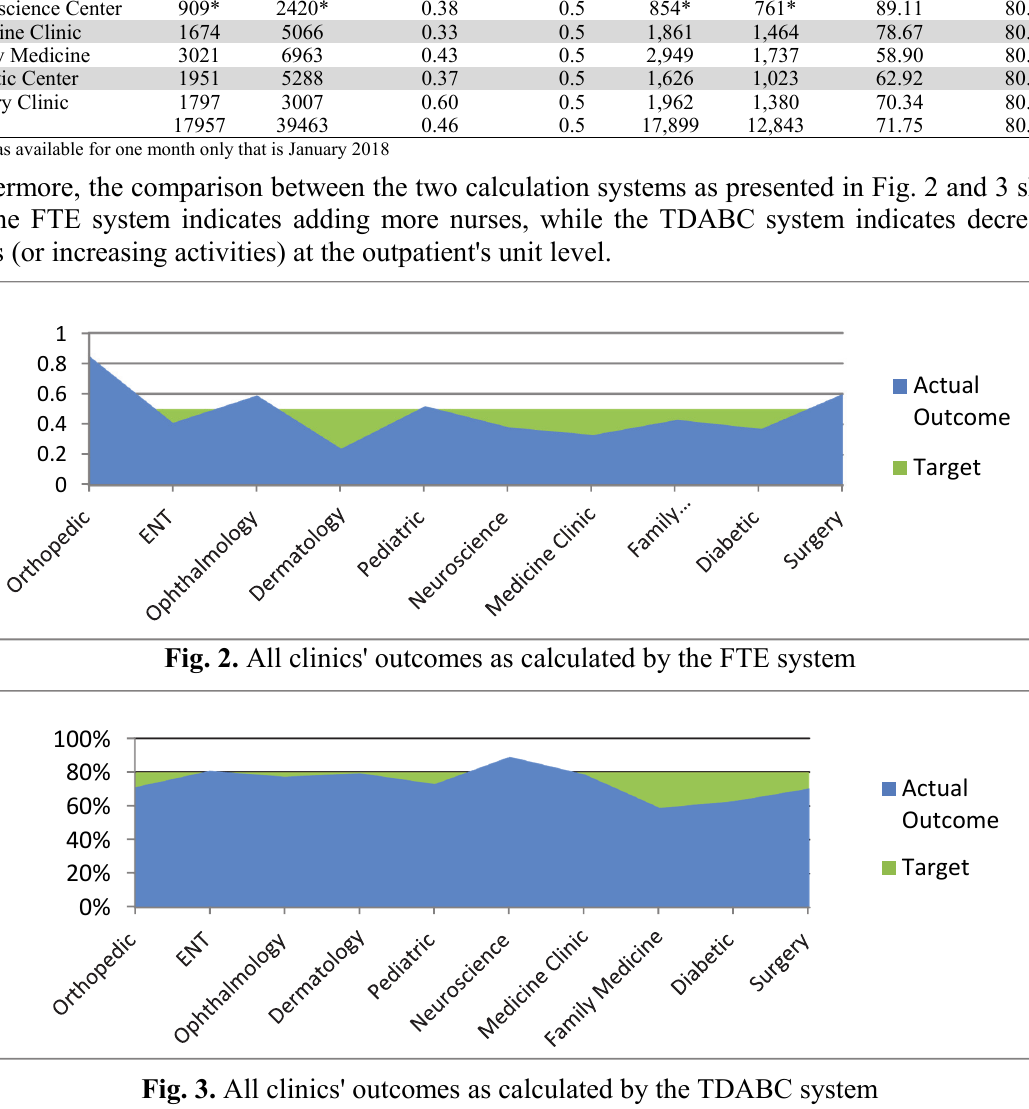
Fig. 3. All clinics' outcomes as calculated by the TDABC